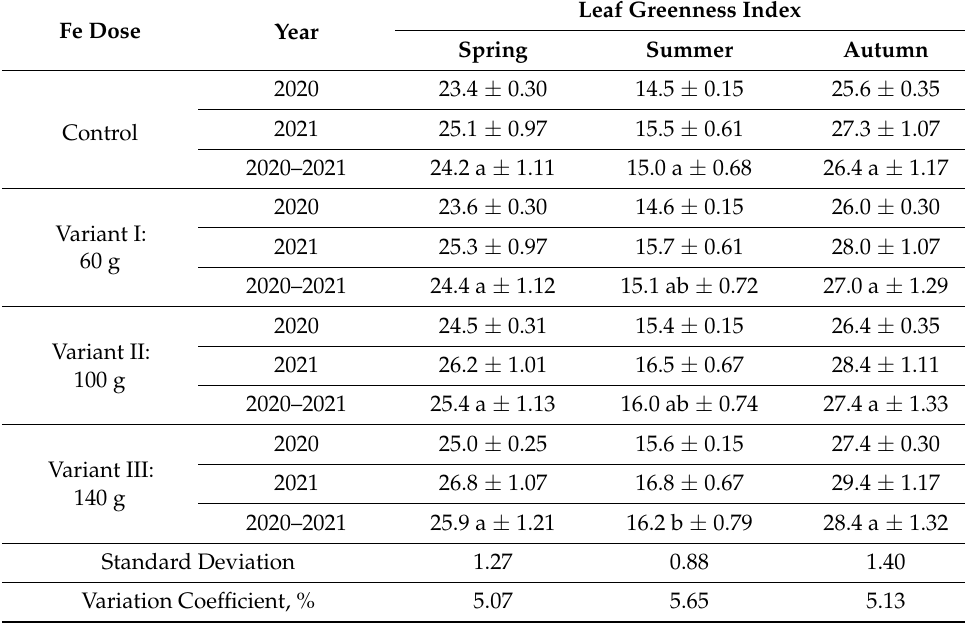
Table 4. Effects of Fe fertilization on the leaf greenness index. Fe